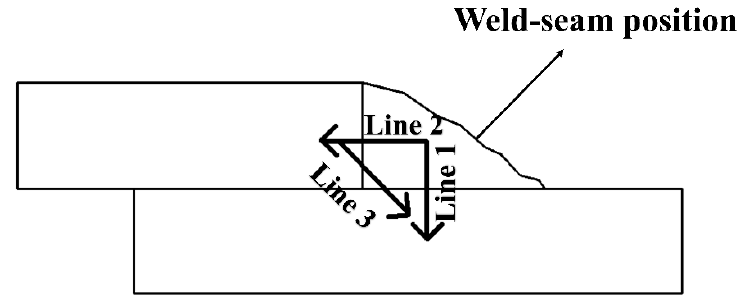
Figure 1. Hardness path diagram.